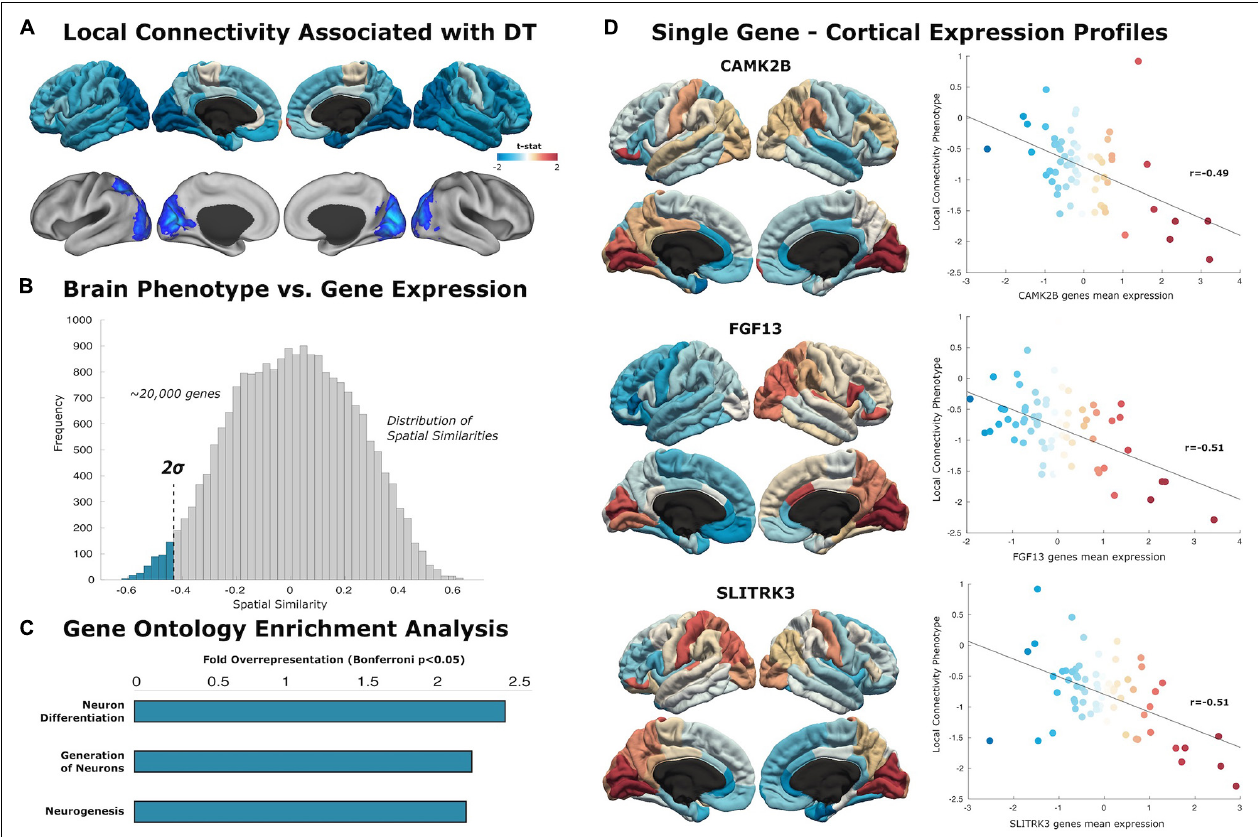
FIGURE 2 | Local connectivity maps. (A) Cortical surfaces display t-statistic of the regression between the local connectivity and DT. Above, data is projected to 68 cortical regions of the Desikan–Killiany atlas to capture mean connectivity across these regions. Below, projection of the t-statistic at the voxel-level, showing regions that survive to multiple comparison with cluster wise Monte Carlo simulation. Each analysis result is displayed in left and right hemispheric surfaces, with lateral and medial projections. (B) The similarity distribution represents the results of topographical similarity analysis between the local connectivity network and the brain transcriptome maps ( ∼ 20,000 protein-coding genes). Genes which have a highly negative similarity score (below dotted line at 2 SDs) are inversely related to our local connectivity map, meaning they are highly expressed in regions with low connectivity. (C) Gene Ontology enrichment analysis reveals this subset of 363 genes exhibit overrepresented functionalities in key domains of neuron generation and differentiation (FE > 2; statistically significant FDR-corrected q < 0.05). (D) Scatterplots show the spatial similarity relationship throughout brain regions between independent expression of three genes (CAMK2B, FGF13, and SLITRK3) and the local connectivity map (linear fit represented with a black